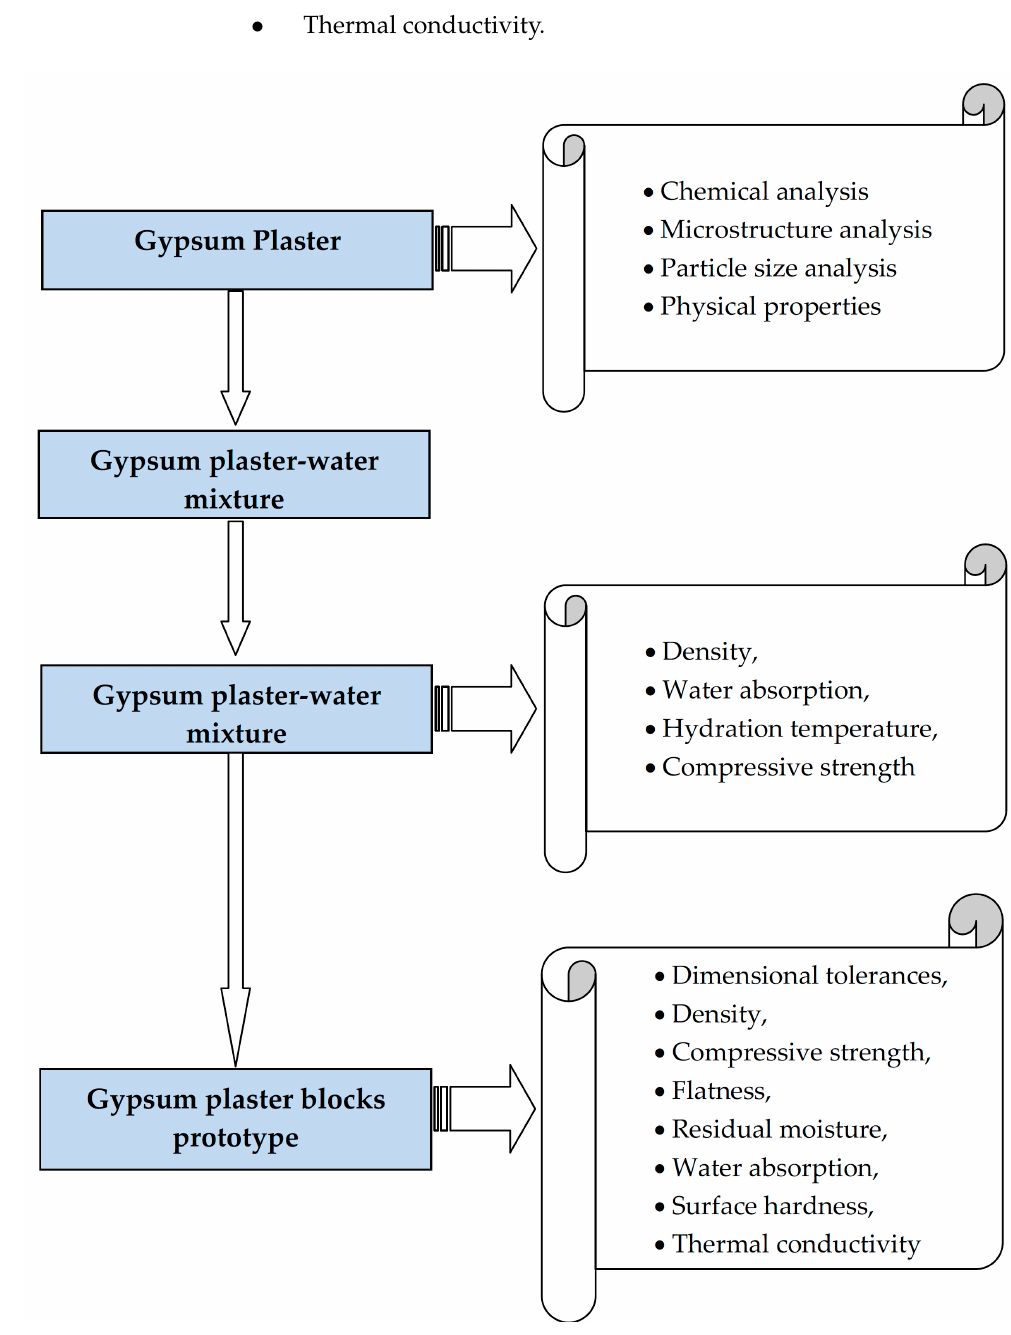
Figure 1. Experimental study flow